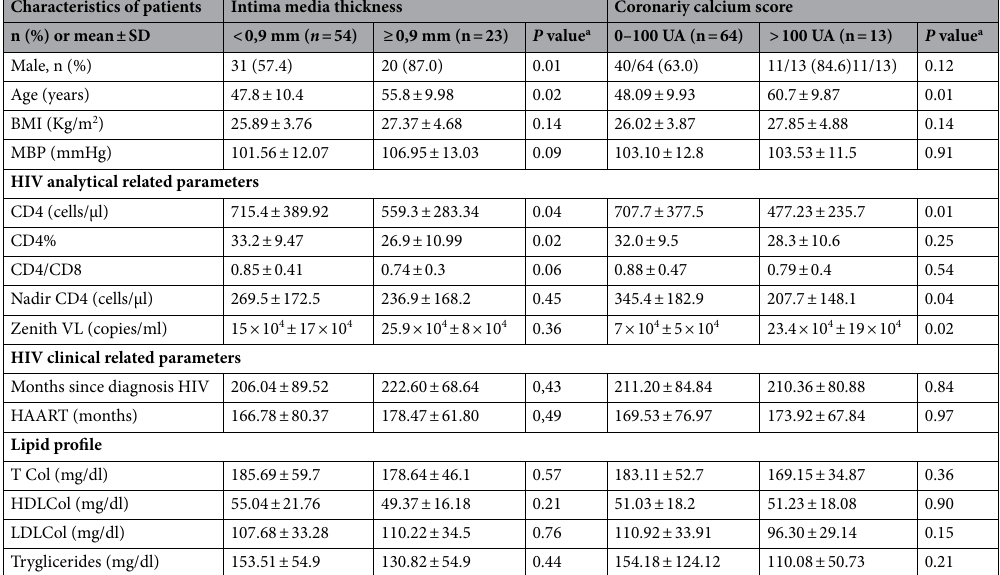
Table 2. Clinical and analytical factors associated with subclinical atherosclerosis in patients with HIV infection. SD standard deviation, u-CRP ultrasensitive C-reactive protein, VL viral load, TCol total cholesterol, HDLCol cholesterol bound to high density lipoproteins, LDLCol cholesterol bound to low density lipoproteins, Tg triglycerides, MBP mean blood pressure. a Two-tailed one-way ANOVA